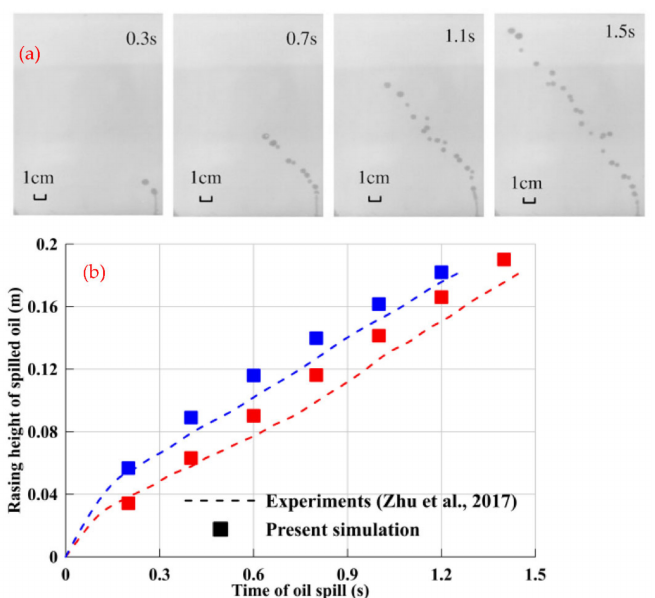
Figure 3. Validation of CFD model against experimental data [11]. ( a ) oil spill experiment; ( b ) CFD results against experimental